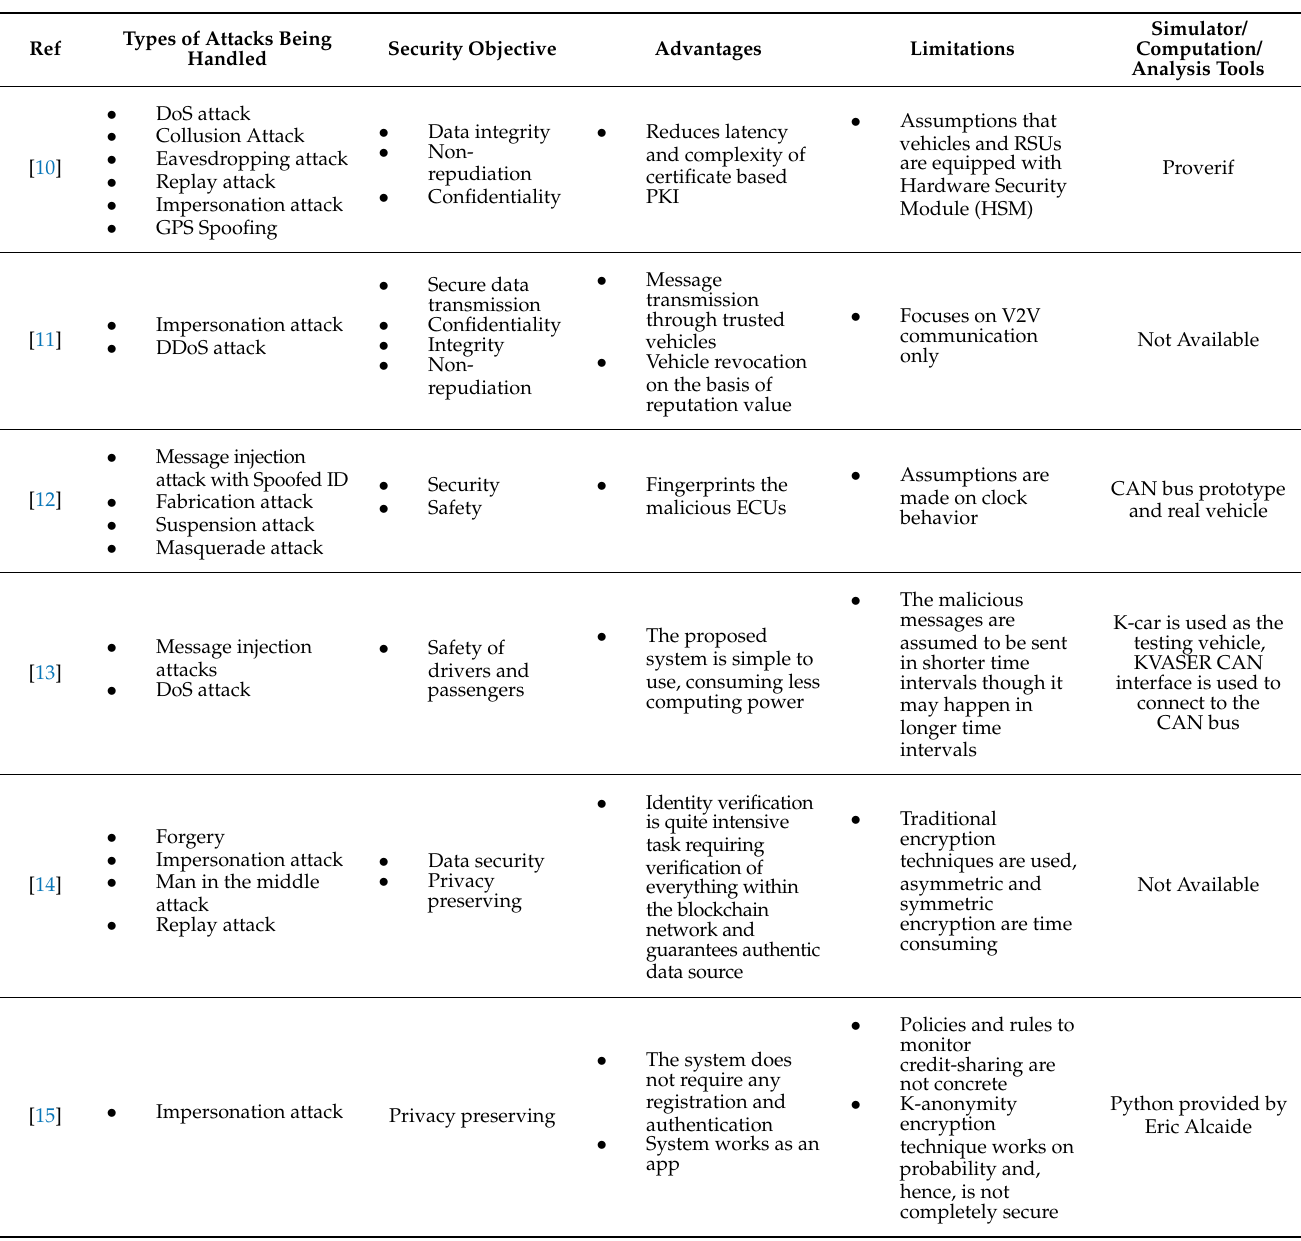
Table A1. Summary of the Literature